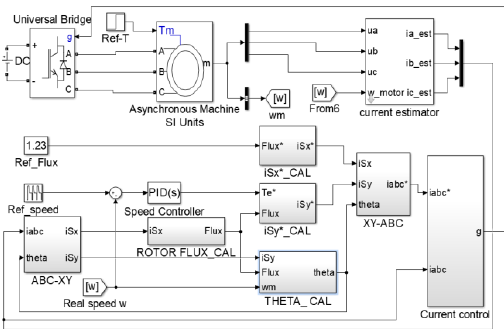
Fig. 5. General Simulink simulation scheme Fig. 5: General Simulink simulation